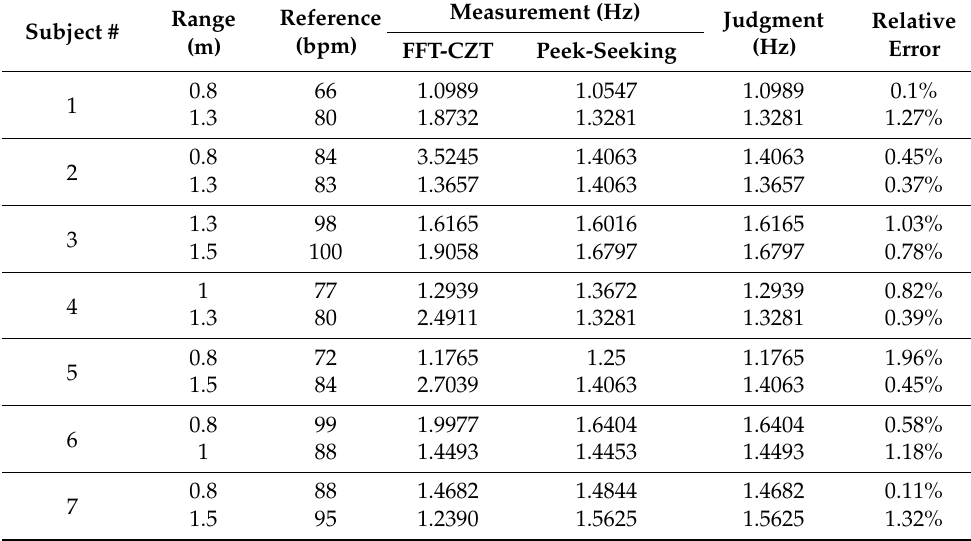
Table 3. Heart rate decision result of group #1.